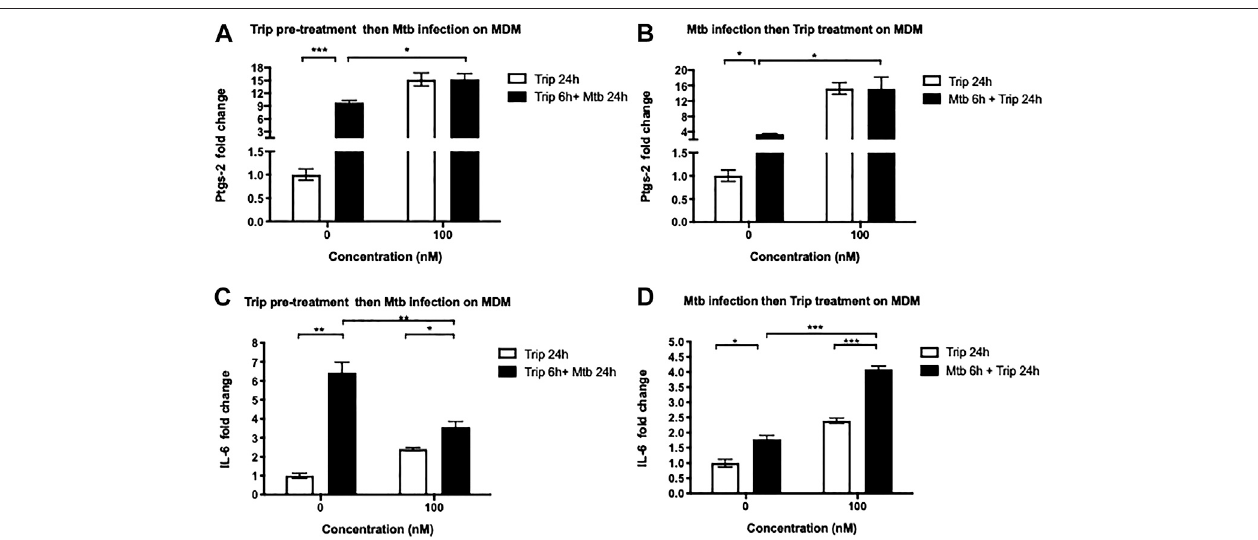
FIGURE 4 | Triptolide pretreatment decreases Mtb HN878-induced expression of IL-6 and Ptgs-2 but posttreatment further increases their expression in MDMs. triptolide pretreatment (A, C) : MDMs were pretreated with the indicated concentrations of triptolide for 6 h then infected with Mtb HN878 MOI:2 up to 24 h. DMSO was used as vector control. Total RNA was extracted then IL-6 (A) and Ptgs-2 (C) expression levels were assessed by RT-qPCR. Triptolide post-treatment (B, D) : MDMswereinfectedwithMtbHN878MOI:2 for6 hthentreatedwiththeindicatedconcentrationsoftriptolideupto24 h.DMSOwasusedasvectorcontrol.Total RNAwasextractedthenIL-6 (B) and Ptgs-2 (D) expression levels wereassessed byRT-qPCR.Relative expression wascalculatedusing the − ΔΔ Ct method.* p < 0.05; ** p < 0.01; *** p < 0.001.